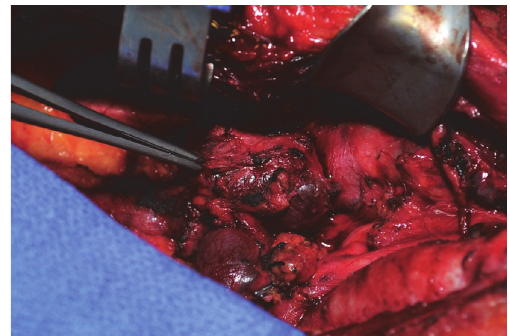
Figure 3: Intraoperative photograph showing an invasive mass obstructing the superior vena cava at the confluence of the right internal jugular and right innominate vein. Patient’s head is to the right, and patient’s right is at the top of the